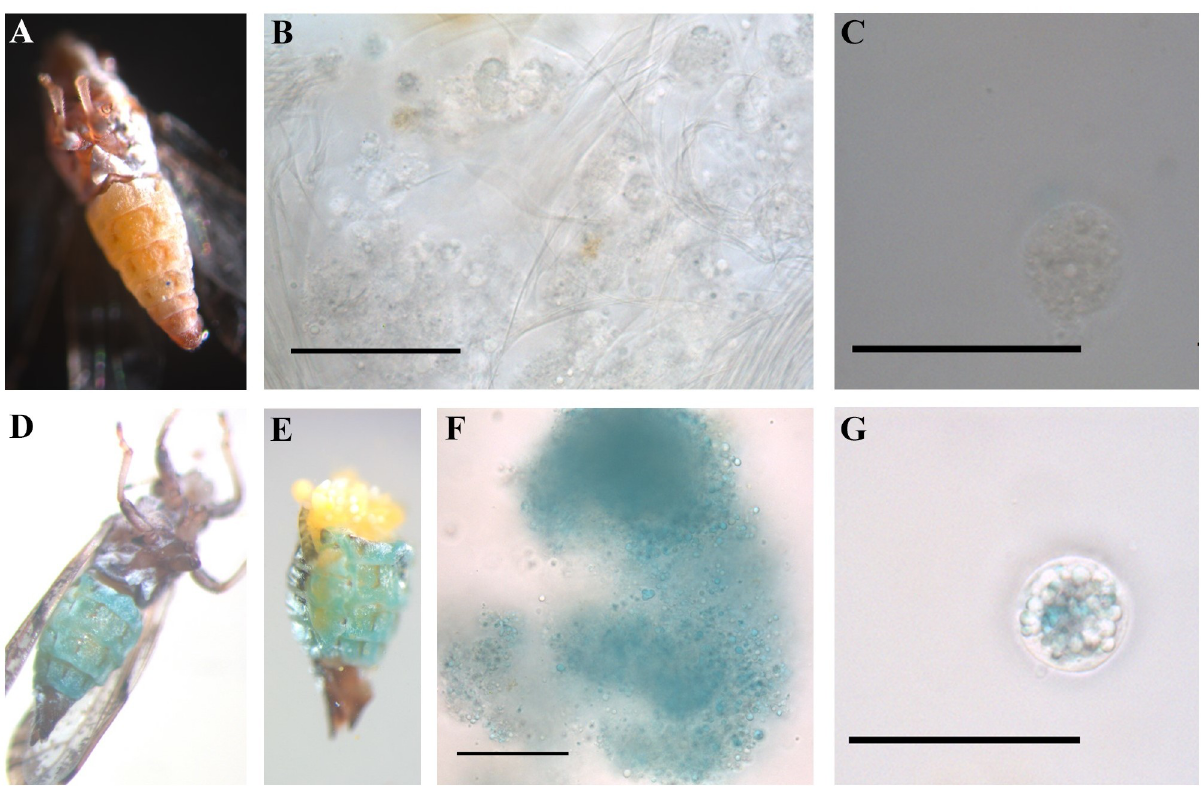
Fig 1. Blue D . citri body color originates from sub-cellular blue pigmentation of the fat body cells as shown during live dissection imaging. Dissections occurred under natural light in 1xPBS and are not fixed. (A) Ventral view of a non-blue male D . citri . (B) Fat body cells from a non-blue adult. (C) Single fat body cell from non-blue adult showing droplet-like composition of cell and transparency. (D) Ventral view of blue, adult, female D . citri . (E) Ventral view of the blue, adult female from (D), after separating the abdomen from the thorax and beginning to remove internal organs. (F) Loose cloud of fat body cells from the blue, adult female in (D), showing higher intensity of blue color in areas with higher concentration of cells, as well as delicate nature of the fat body organ and ephemeral nature of individual cell cohesion. (G) Single fat body cell from blue, adult female in (D), showing droplet-like composition of cells where some droplets are pigmented bright blue, and cells vary in size.